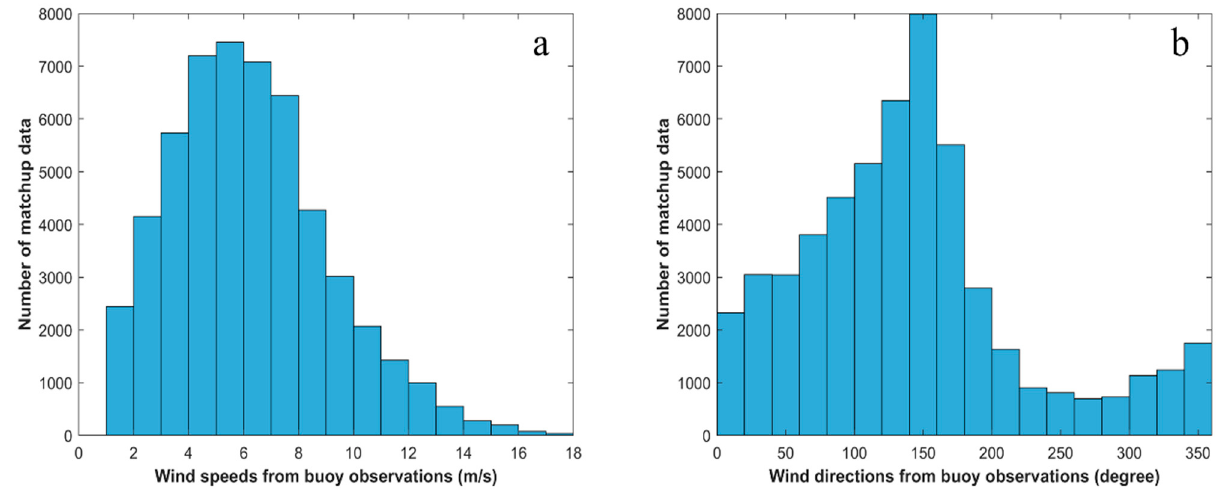
Figure 3. Histogram of collocated in situ ( a ) wind speeds and ( b ) wind directions from NDBC buoys. To further validate the proposed method using NDBC data against an independent data